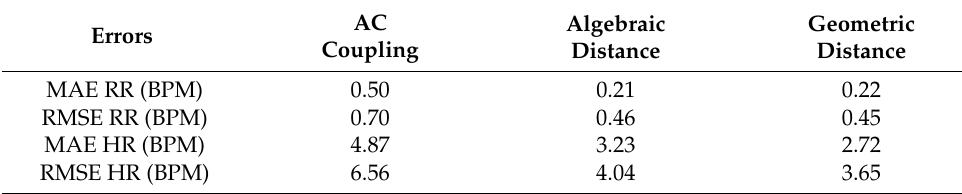
Table 3. Experimental results using the mmWave radar.